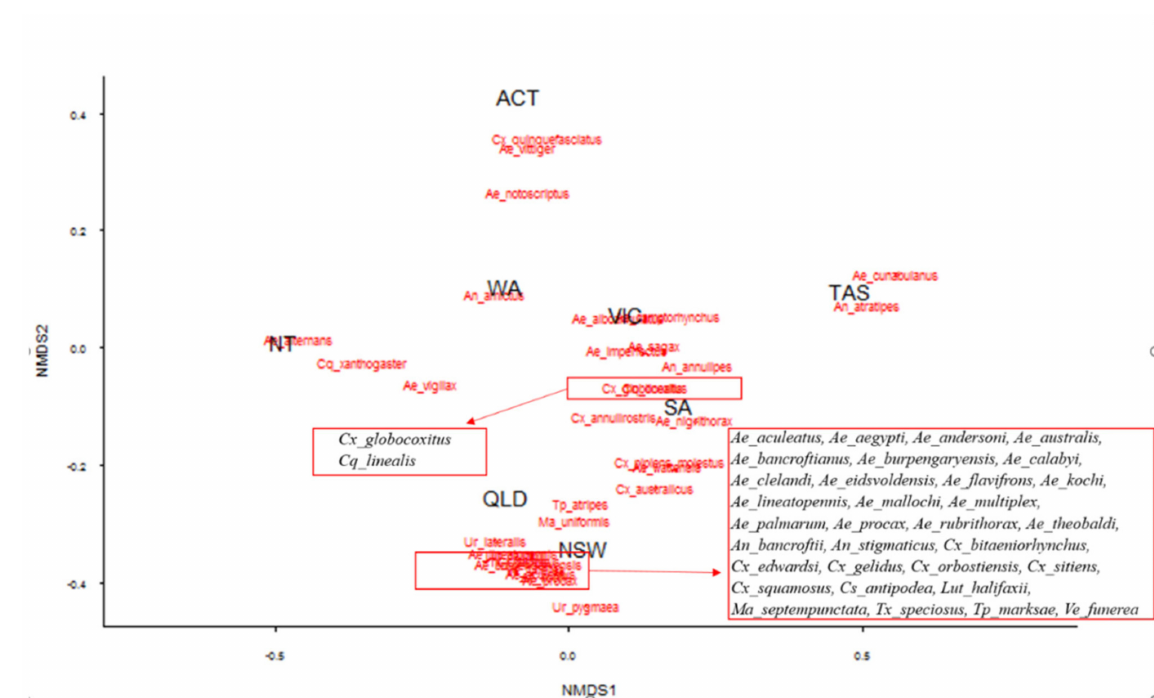
Figure 2. Contribution of mosquito species richness observed per state and territory through a dissimilarity analysis using non-metric multidimensional scaling tool. Axis x and y show non-metric multidimensional scaling dimensions using Bray-Curtis distances for community-by-site matrix.